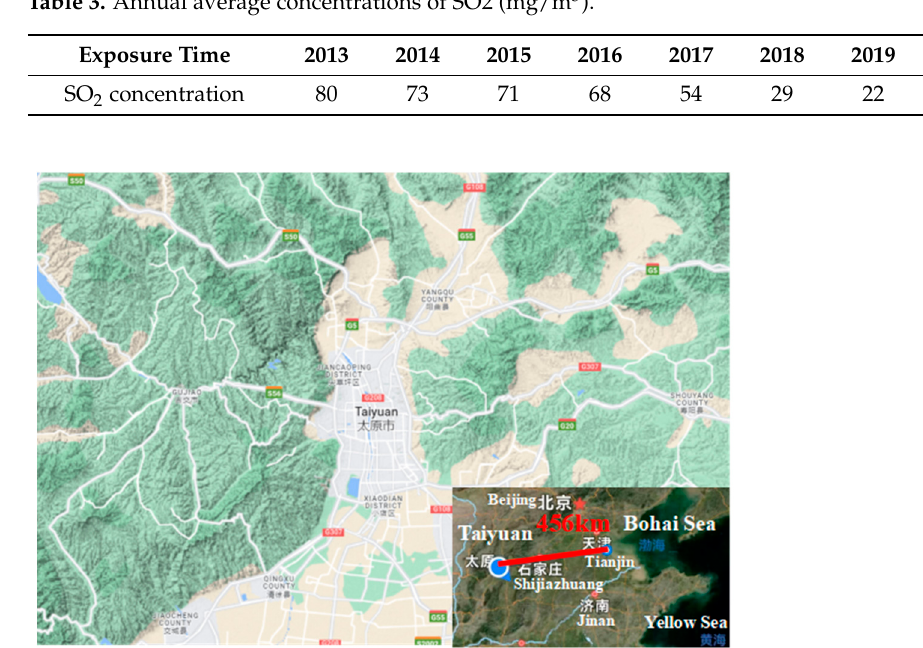
Table 3. Annual average concentrations of SO2 (mg/m 3 ).